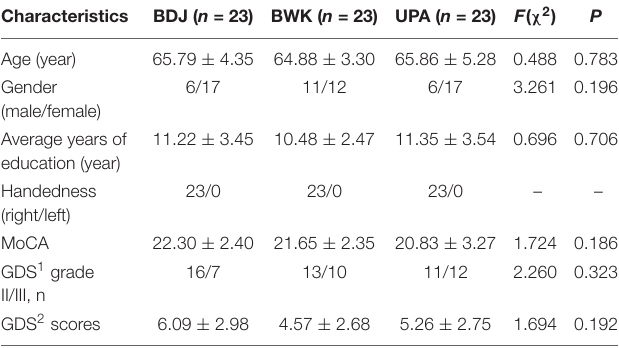
TABLE 1 | Baseline characteristics of the participants (mean ±